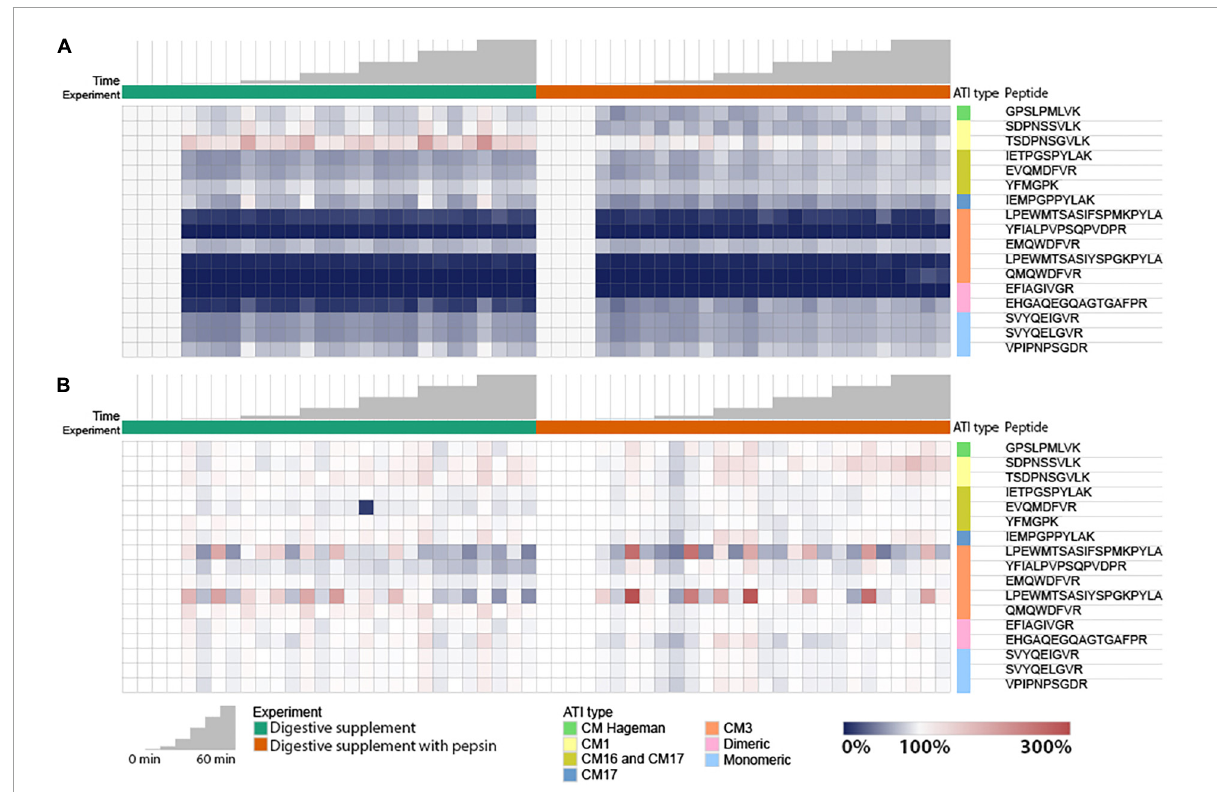
FIGURE5 Relative abundance changes of the tryptic ATI peptides digested by: caricain (A) ; and An-Pep (B) ; in non-reducing conditions in absence (left) and presence (right) of pepsin. Each value (peptide peak area) was normalized to its own 0 time point value.